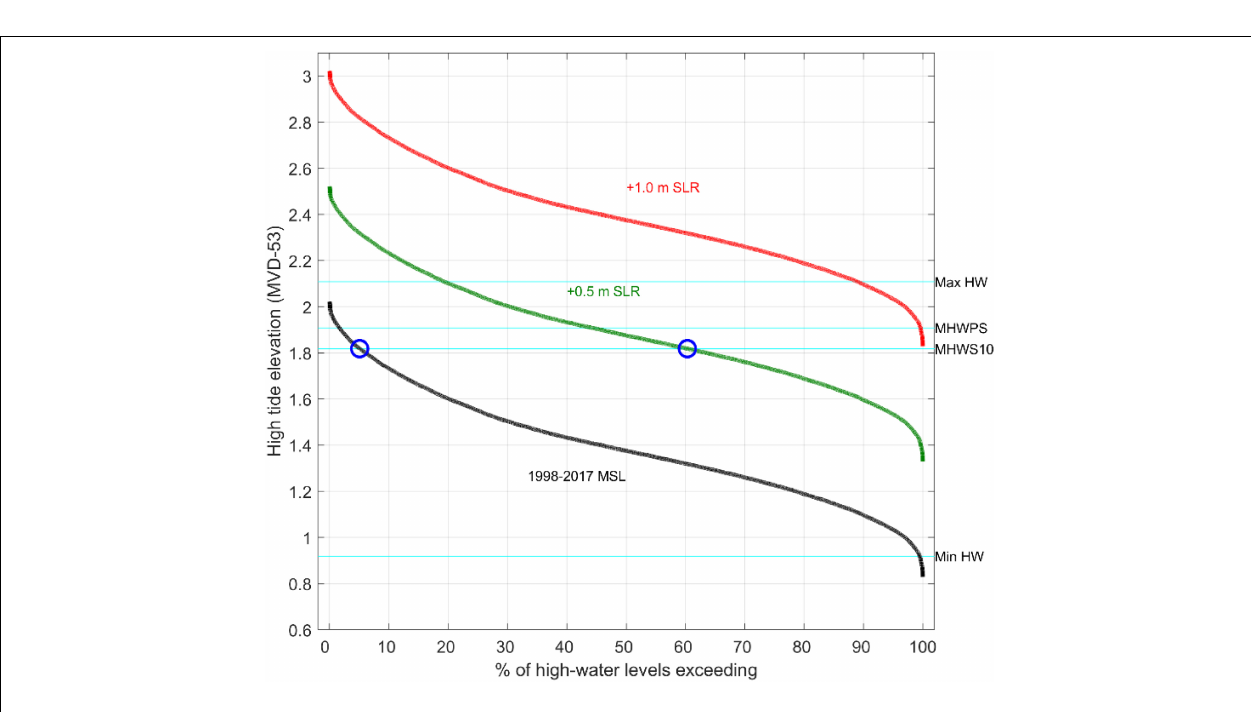
Frontiers in Marine Science |